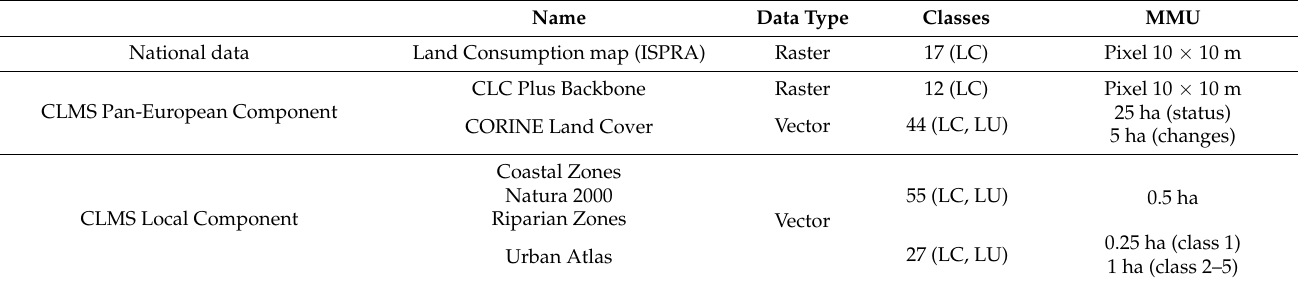
Table 2. Input data used for the mapping of ecosystem types and to produce the land cover map used for the ecosystem services assessment; LC= Land Cover classes, LU= Land Use classes, CLMS= Copernicus Land Monitoring